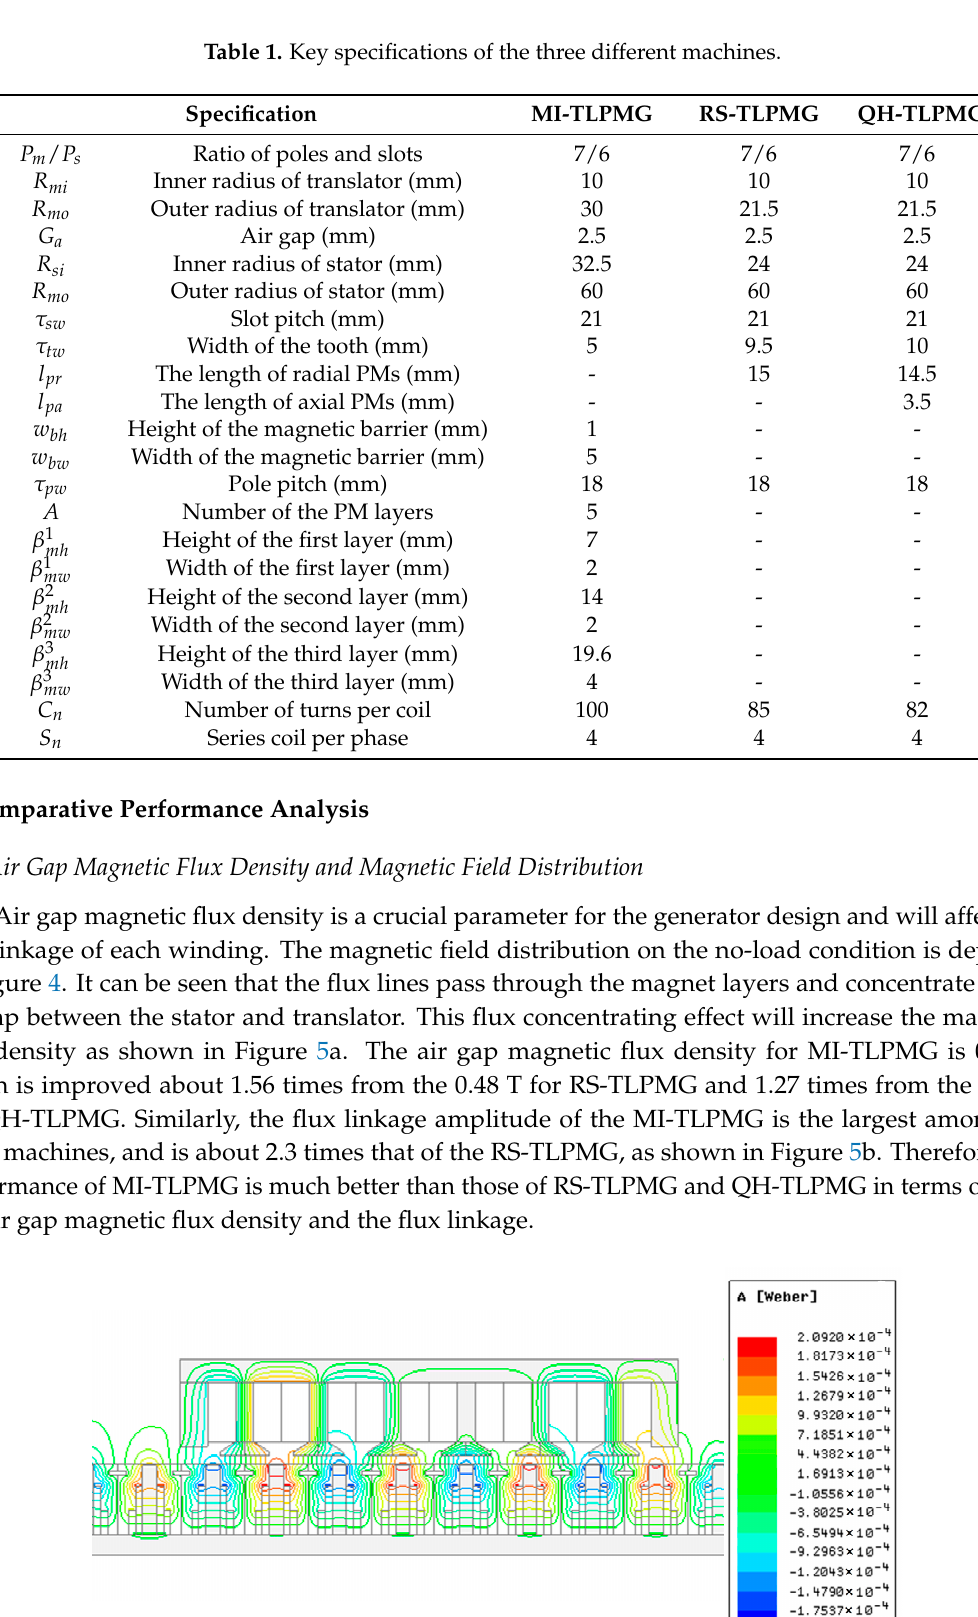
( b ) Figure 5. Air gap magnetic flux density and three-phase flux linkage on the no-load condition: ( a ) magnetic flux density; ( b ) three-phase flux linkage. 3.2. Performance Analysis at a Constant Speed Under real oceanic conditions, the speed of waves is not a constant value. Consequently, the direct-drive WEC system is a nonuniform motion. In order to facilitate the analysis of the generators, the speed of the translator is assumed to be a constant value in the initial design stage, i.e., 0.4 m/s. The back-EMF, load performance, output power, and efficiency of the three machines are investigated and compared by using FEA in this section. Figure 6 shows the phase and line open-circuit back-EMF of MI-TLPMG, RS-TLPMG, and QH- TLPMG at the constant speed of 0.4 m/s. As shown in Figure 6a, the no-load phase back-EMFs are approximately sinusoid and are symmetric with each other. This validates the correctness of the machine design. The phase back-EMF amplitudes of MI-TLPMG, RS-TLPMG, and QH-TLPMG are about 20 V, 9.5 V, and 10.5 V, respectively. This indicates that the back-EMF of MI-TLPMG is significantly higher than that of the other machines. Based on the Fourier analysis, Figure 6b shows a high three-order harmonic existing in the phase back-EMF of MI-TLPMG. However, the three-order harmonic could be eliminated by employing star-connection armature windings as shown in Figure 6d. Then, from Figure 6c, it can be seen that the line back-EMF waveform of the MI-TLPMG is more sinusoidal and the total harmonic distortion (THD) of the back-EMF is less than 1.9%.